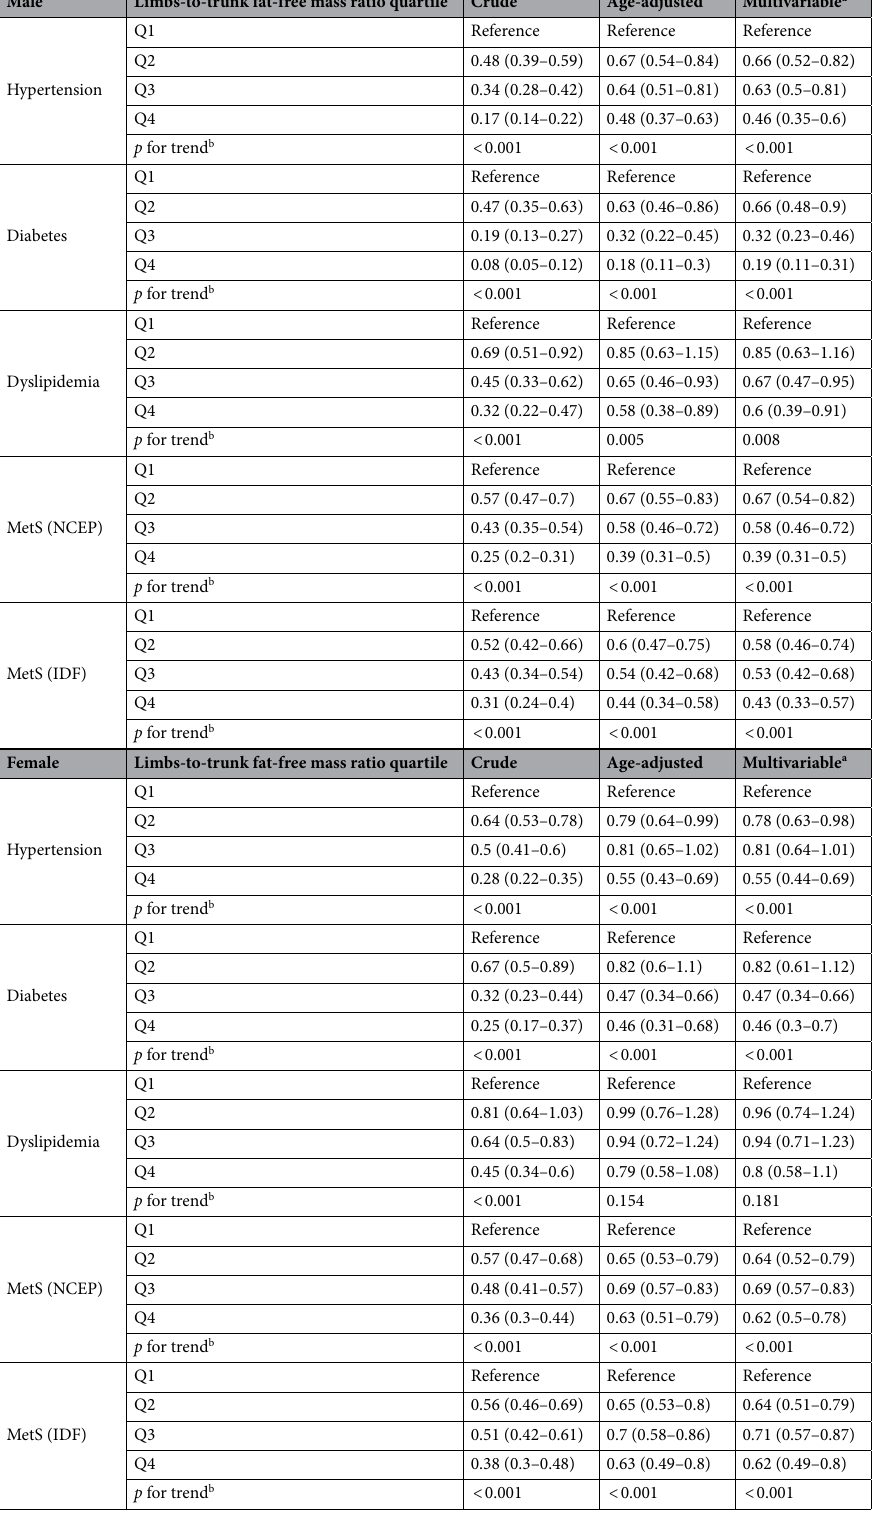
Table 6. Odds ratios for cardiovascular disease risk factors according to limbs-to-trunk fat-free mass ratio quartile. Data are presented as odds ratio (95% confidence interval). MetS, metabolic syndrome; NCEP, 2005 National Cholesterol Education Program Adult Treatment Panel III; IDF, 2006 International Diabetes Federation. a Multivariable model adjusted for age, energy intake, water intake per body weight, smoking, alcohol drinking, physical activity, education, income, and survey year. b Test for linear trend across quartile of limbs-to-trunk fat-free mass